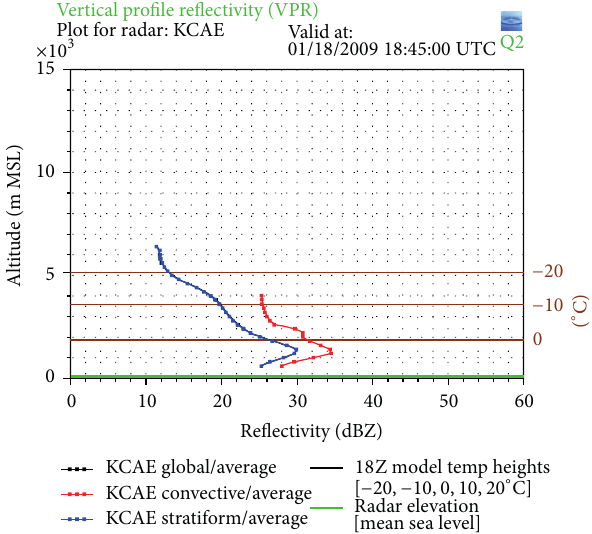
Figure 5: The vertical profile of reflectivity from Columbia, SC. The blue line indicates the reflectivity values for stratiform precipitation, where the peak shows the brightband